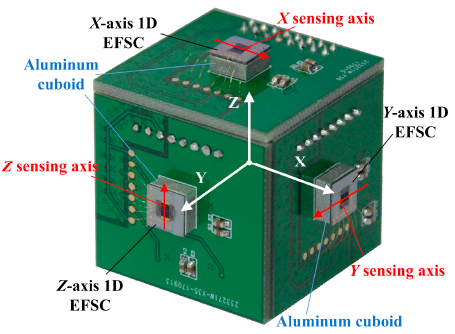
Figure 6. The 3D electric field sensor (EFS) and its local coordinate system. These three printed circuit boards (PCBs) formed three orthogonal facets of a cube. The center of the cube is coincident with the origin of the coordinates. The size of 3D EFS is 3 cm × 3 cm × 3 cm.